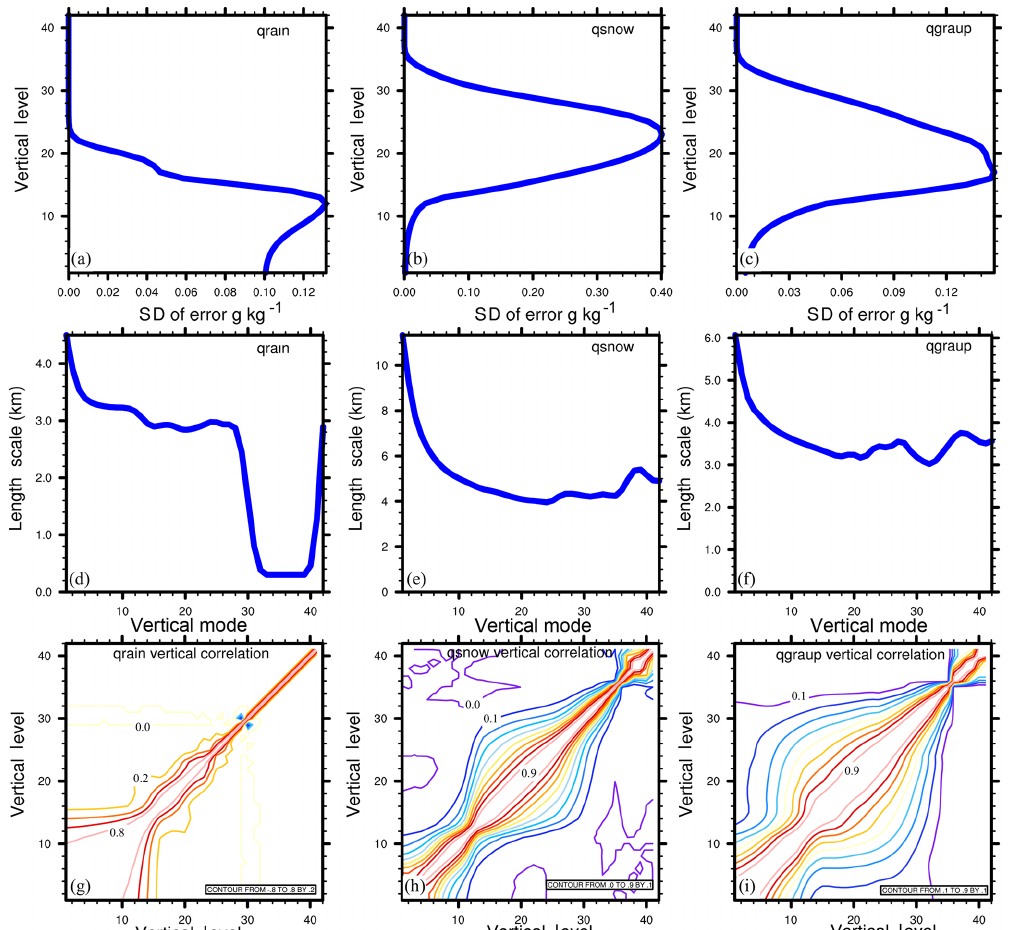
Figure 3. (a–c) The standard deviations of the background errors at different vertical levels, (d–f) the horizontal correlation length scale as a function of EOF mode, and (g–i) the vertical correlation coefficients for q r , q s , and q g